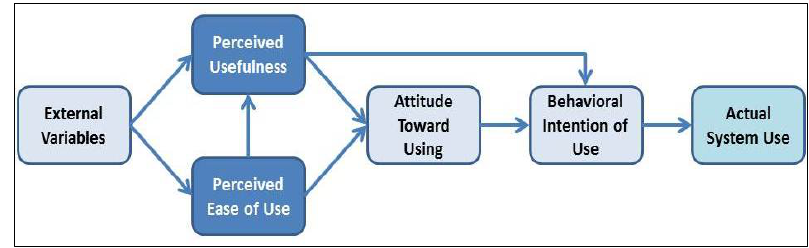
Figure 1: The Technology Acceptance Model